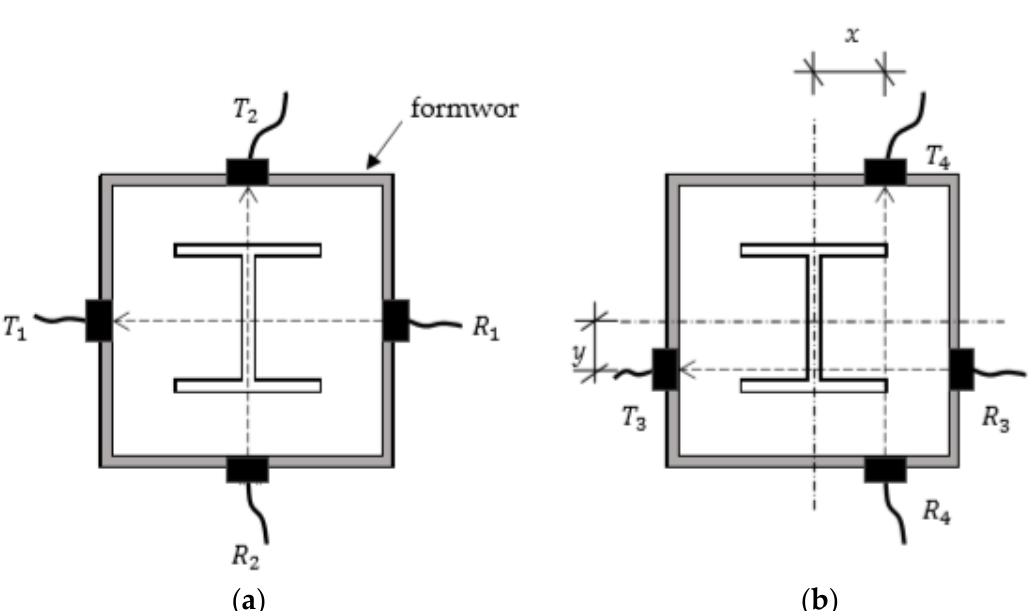
Figure 1. Combination of transmitter (T) and receiver (R) location (a) at center of section and (b) with offset from center.